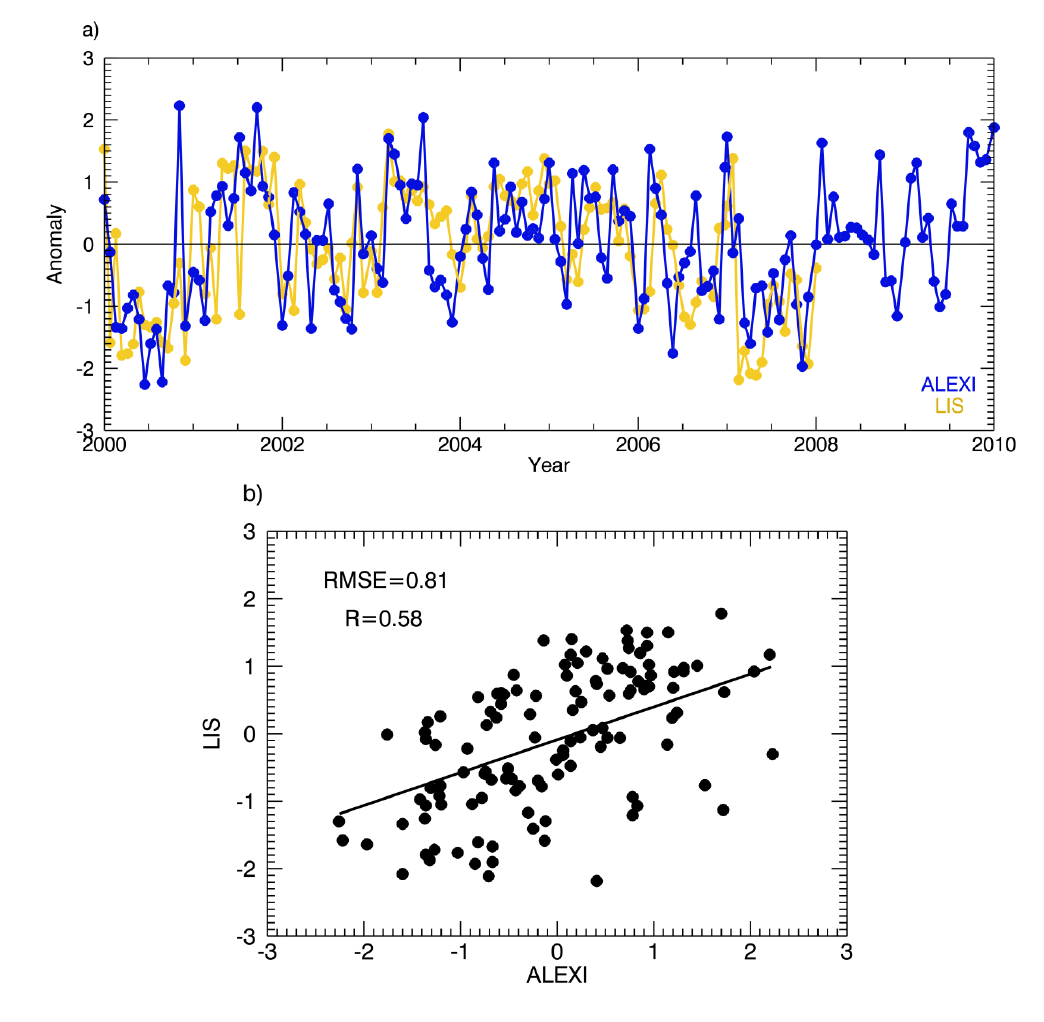
Figure 1. ( a ) Anomaly time series plot between LIS (yellow) and ALEXI (blue) 14-day soil moisture composite at Belle Mina, Alabama for the period of 2000–2010; ( b ) Scatter plot of the anomalies between LIS and ALEXI again at the Belle Mina,